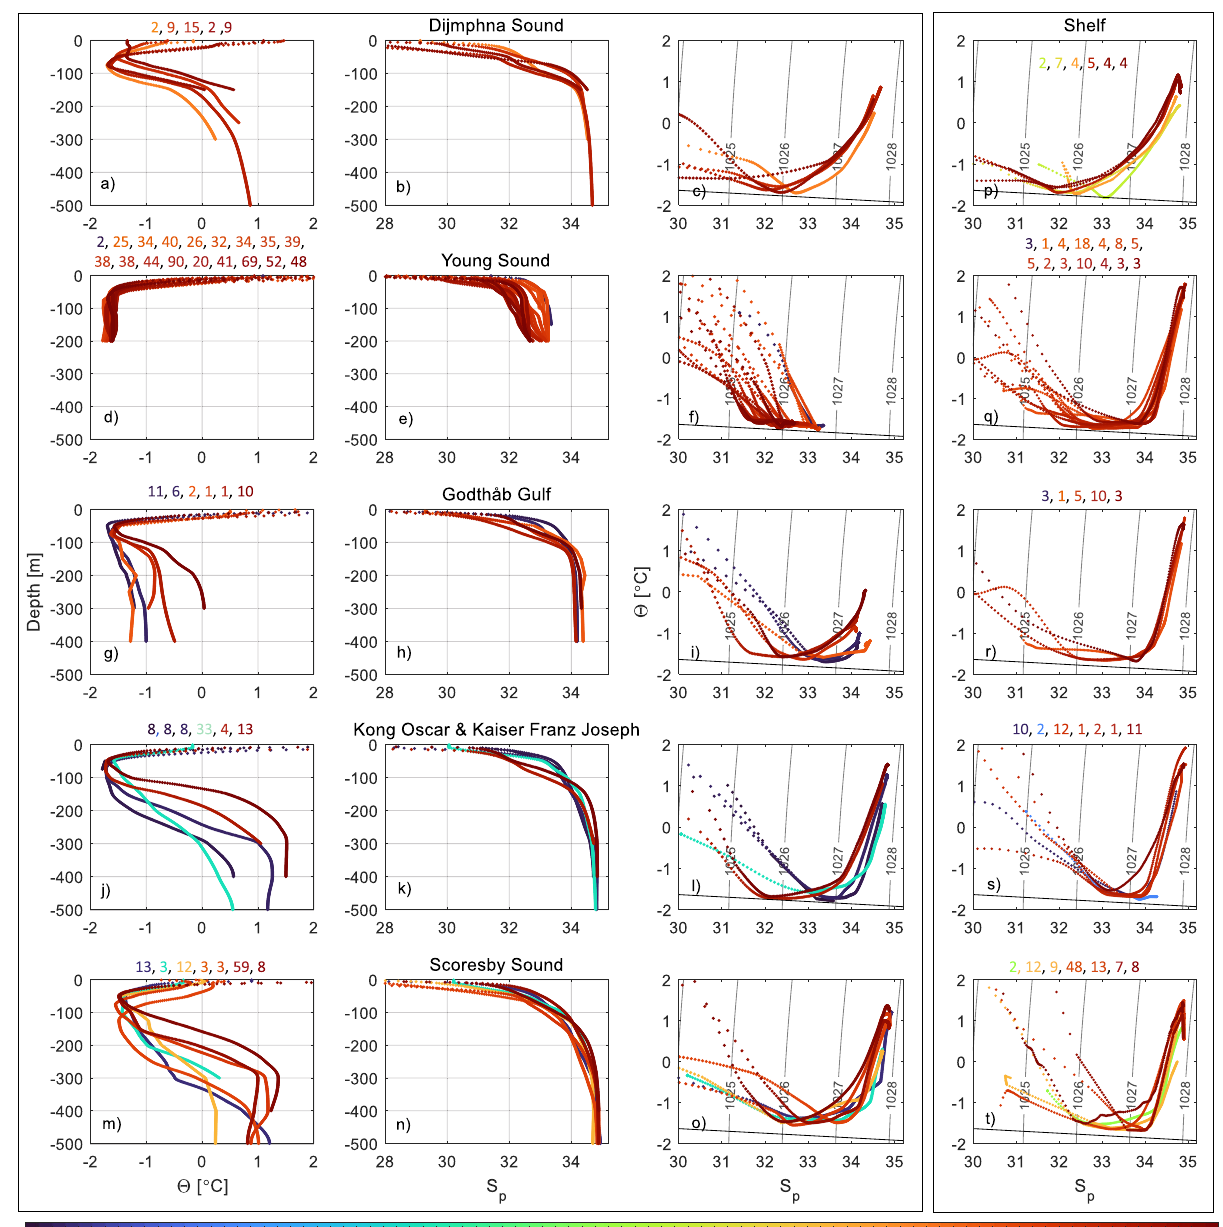
temperature-salinity (T/S) diagrams ( fi rst, second, and third columns) for the individual fjord systems included in the current study. Dijmphna Sound ( a – c